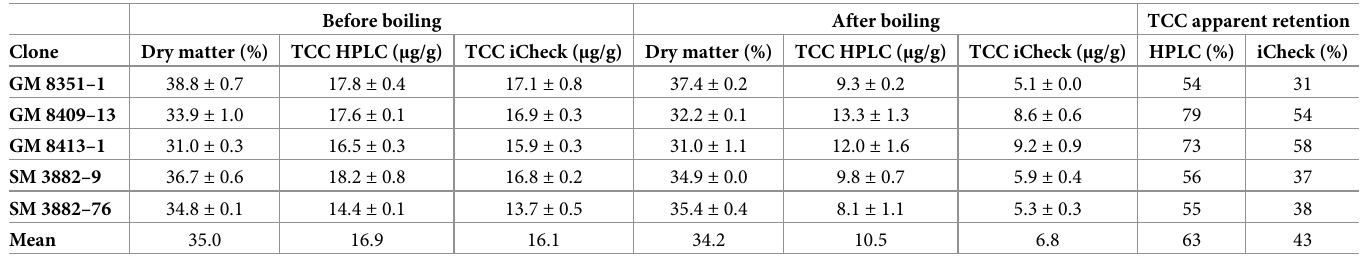
Table 2. TCC, dry matter, and apparent retention of five yellow cassava lines before and after boiling measured by HPLC and iCheck Carotene. Before